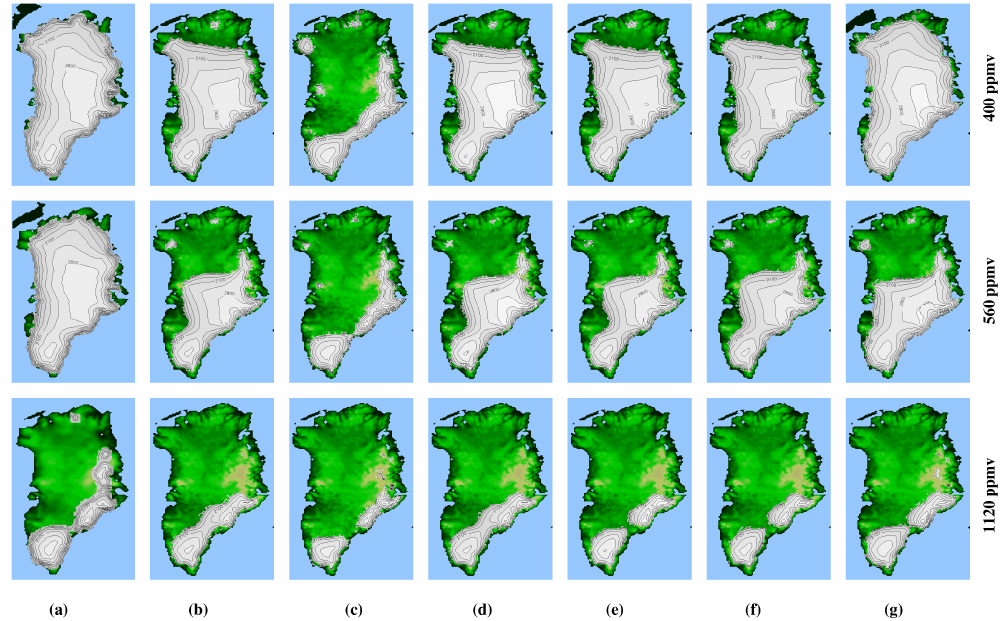
Fig. 12. Ice-sheet geometry for future warming scenarios (400ppmv, 560ppmv and 1120ppmvCO 2 ) for (a) standard EISMINT-3 setup as shown in Lunt et al. (2009) and (b) to (g) the selected parameter sets from tuning (experiment numbers 10, 67, 99, 165, 233 and 240 respectively). See Table 5 for the tuned parameter sets corresponding to these particular